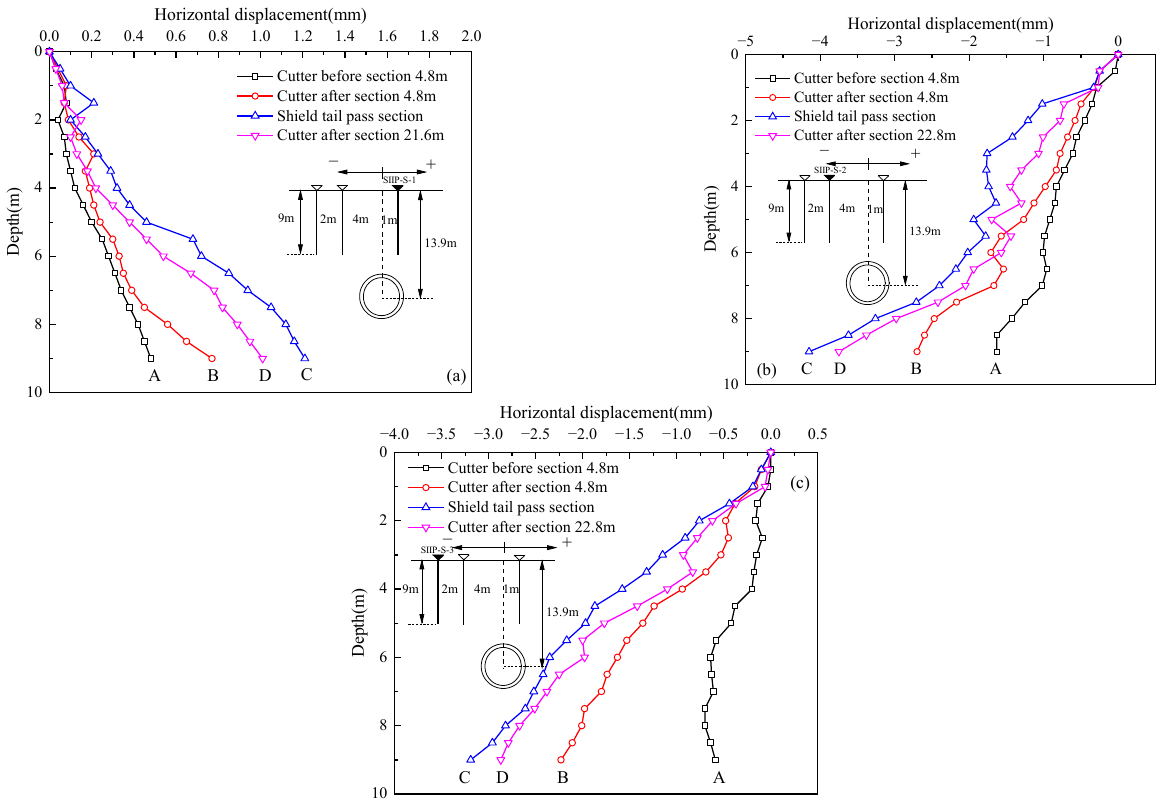
Figure 11. Horizontal displacement of stratum soil in monitoring section A: ( a ) SIIP-S-1; ( b ) SIIP-S-2; and ( c ) SIIP-S-3. Figure 12 is the horizontal displacement curve of each measuring point during the monitoring of section B at different times. The monitoring results show: (1) During shield tunneling, the soil around the tunnel expands and deforms from the point of approach- ing the measuring point to crossing, and the maximum deformation values of SIIP-N-1, SIIP-N-2, and SIIP-N-3 are 1.35 mm, 1.21 mm and 1.08 mm, respectively. Because the shield shell produces extrusion friction with the surrounding soil during construction, it has an obvious disturbance effect on the soil. After the shield tail passes the section, under the influence of grouting pressure at the shield tail, the outward expansion deformation of the soil continues to increase, and the maximum deformation values of SIIP-N-1, SIIP-N-2, and SIIP-N-3 reach 2.46 mm, 2.05 mm and 1.83 mm, respectively. When far away from the mon- itoring section, the excess pore water pressure dissipates, the slurry solidifies and shrinks, and the horizontal deformation of the soil shrinks inward. The maximum deformation val- ues of SIIP-N-1, SIIP-N-2, and SIIP-N-3 reach 2.26 mm, 1.68 mm, and 1.54 mm, respectively. (2) The maximum horizontal displacement of the soil at the south line monitoring point is concentrated at 2–4 mm, and the maximum horizontal displacement of the soil at the north line monitoring point is concentrated at 1–3 mm. This is because the grouting pressure of the south line is concentrated at 0.21–0.27 MPa, while the grouting pressure of the north line is concentrated at 0.18–0.22 MPa, which is much smaller than that of the south line. The grouting pressure has a great impact on soil deformation disturbance. (3) As for the south line, in each tunneling stage, the deformation value close to the tunnel monitoring point is greater than the tunnel monitoring point. This shows that the compaction effect of the surrounding soil is obvious during shield tunneling, and with the distance from the monitoring point of the shield, the horizontal displacement gradually decreases and the compaction effect gradually weakens. This conclusion is consistent with Yu et al.